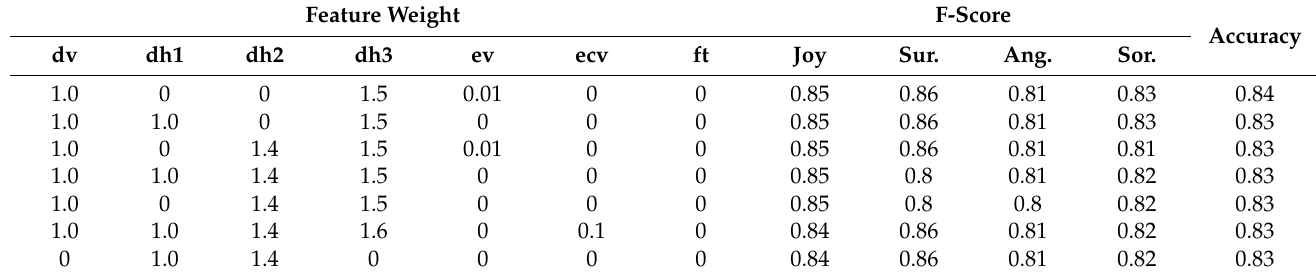
Table 6. F-score and accuracy (top seven accuracy values).